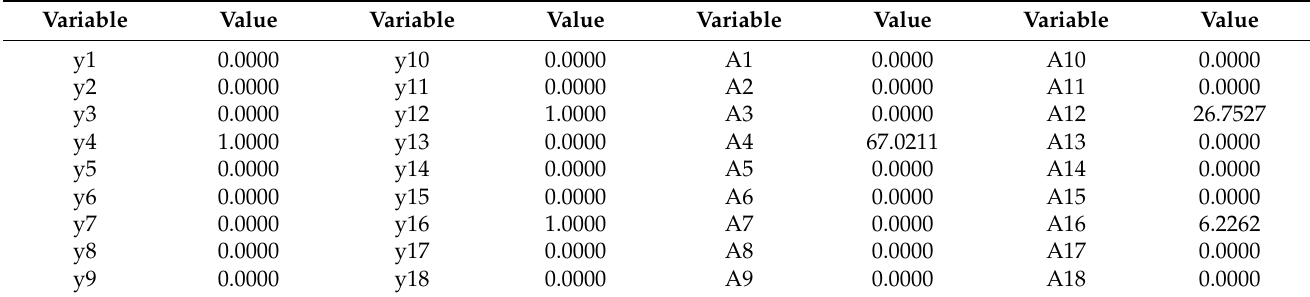
Table 7. The investment portfolio design results with LSTM and the La-VaR.